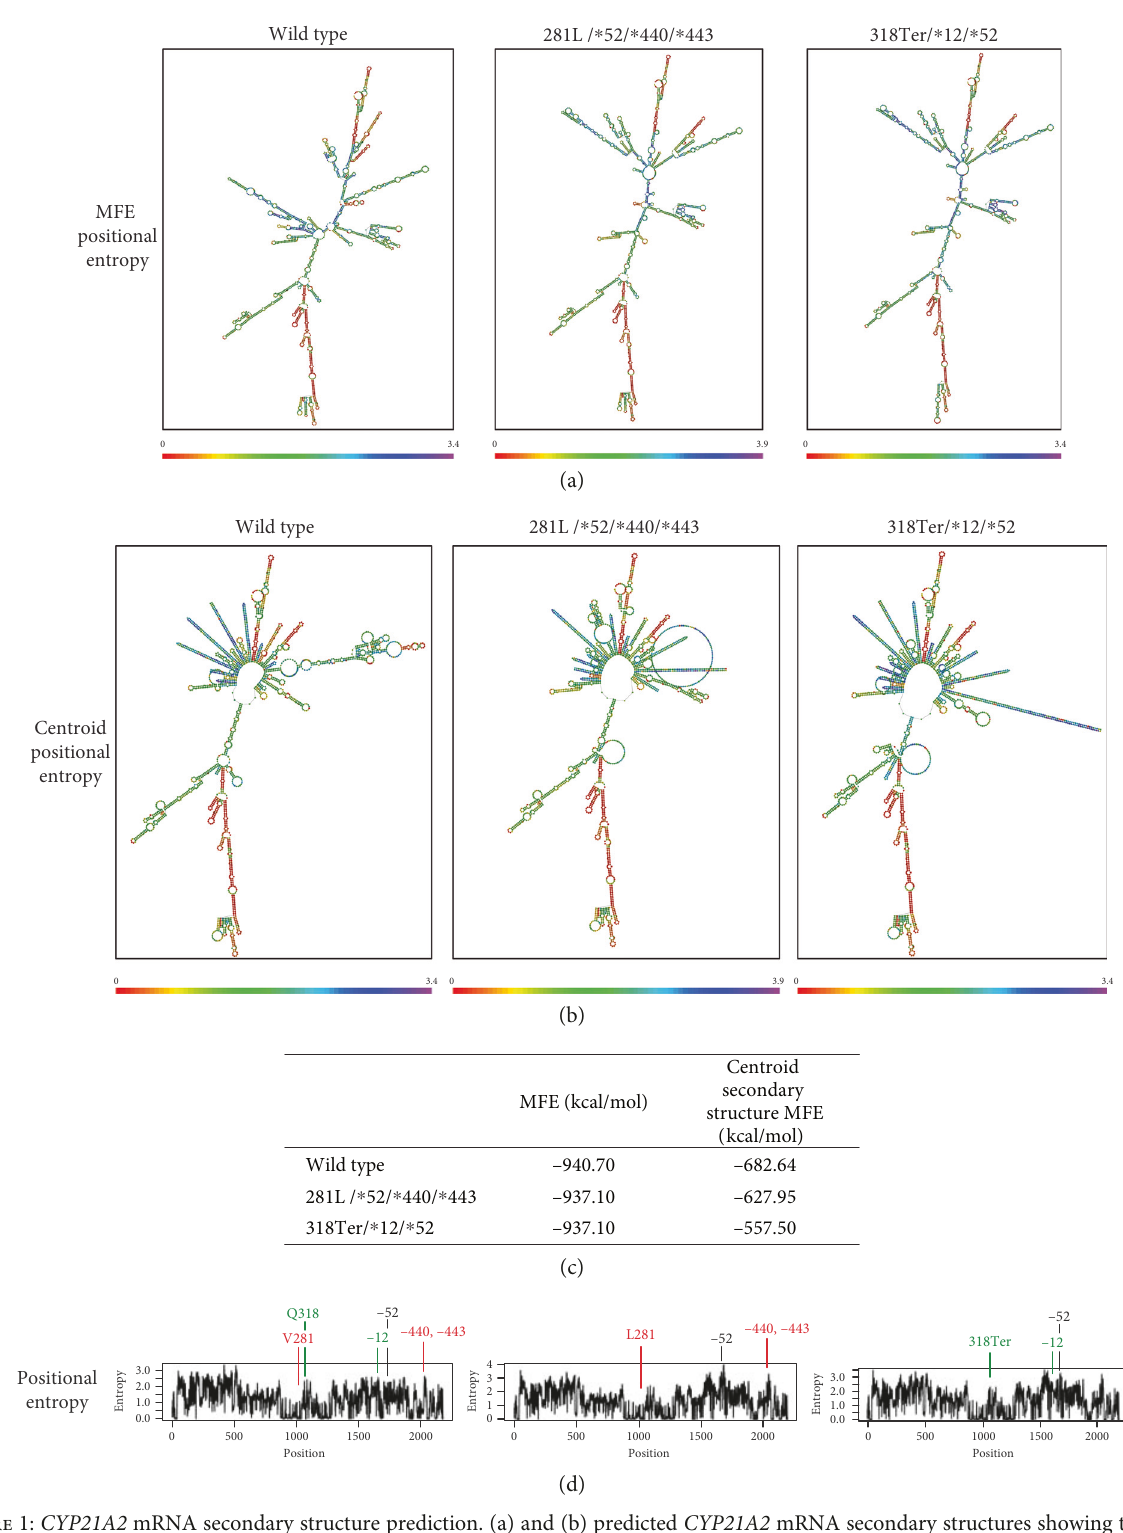
Figure 1: CYP21A2 mRNA secondary structure prediction. (a) and (b) predicted CYP21A2 mRNA secondary structures showing the MFE positional and centroid positional entropy, respectively, for the wild type, 281L/ ∗ 52/ ∗ 440/ ∗ 443 mutant, and 318Ter/ ∗ 12/ ∗ 52 mutant. (c) Minimum free energy (MFE) and centroid secondary structure MFE values. mRNA secondary structures values with 1kcal/mol above the minimum MFE observed in wild type are considered responsible for the destabilisation of the structure [48]. (d) Positional entropies for the wild type, 281L/ ∗ 52/ ∗ 440/ ∗ 443 mutant, and 318Ter/ ∗ 12/ ∗ 52 mutant. Locations of the variations are indicated. 281L/ ∗ 52/ ∗ 440/ ∗ 443 mutant variations are indicated with red colour. 318Ter/ ∗ 12/ ∗ 52 mutant variations are indicated with green colour. ∗ 52 variation which is common in the two mutants is indicated with black